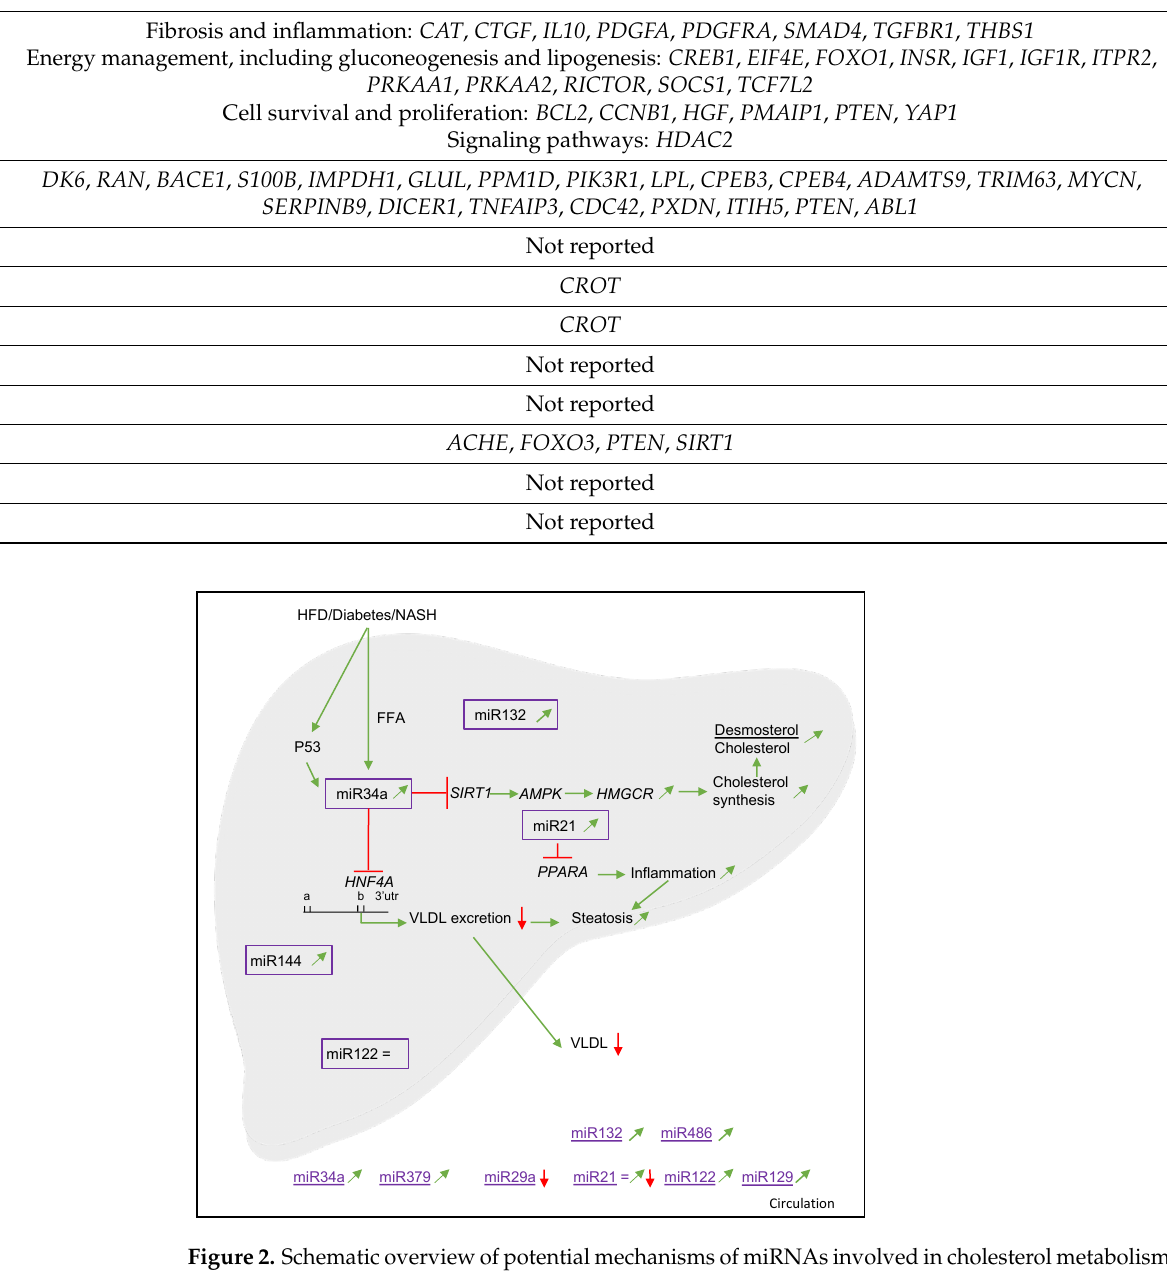
Figure 2. Schematic overview of potential mechanisms of miRNAs involved in cholesterol metabolism in humans. Red arrow is downregulated. Green arrow is upregulated, = is no change. HFD—high- fat diet; NASH—non-alcoholic steatohepatitis; FFA—free fatty acids; SIRT1 —sirtuin1; AMPK —5 (cid:48) - adenosine-monophosphate-activated protein kinase; HMGCR —3-hydroxy-3-methylglutaryl-CoA reductase; HNF4A —hepatocyte nuclear factor 4 alfa; VLDL—very-low-density lipoprotein; PPARA — peroxisome proliferator-activated receptor